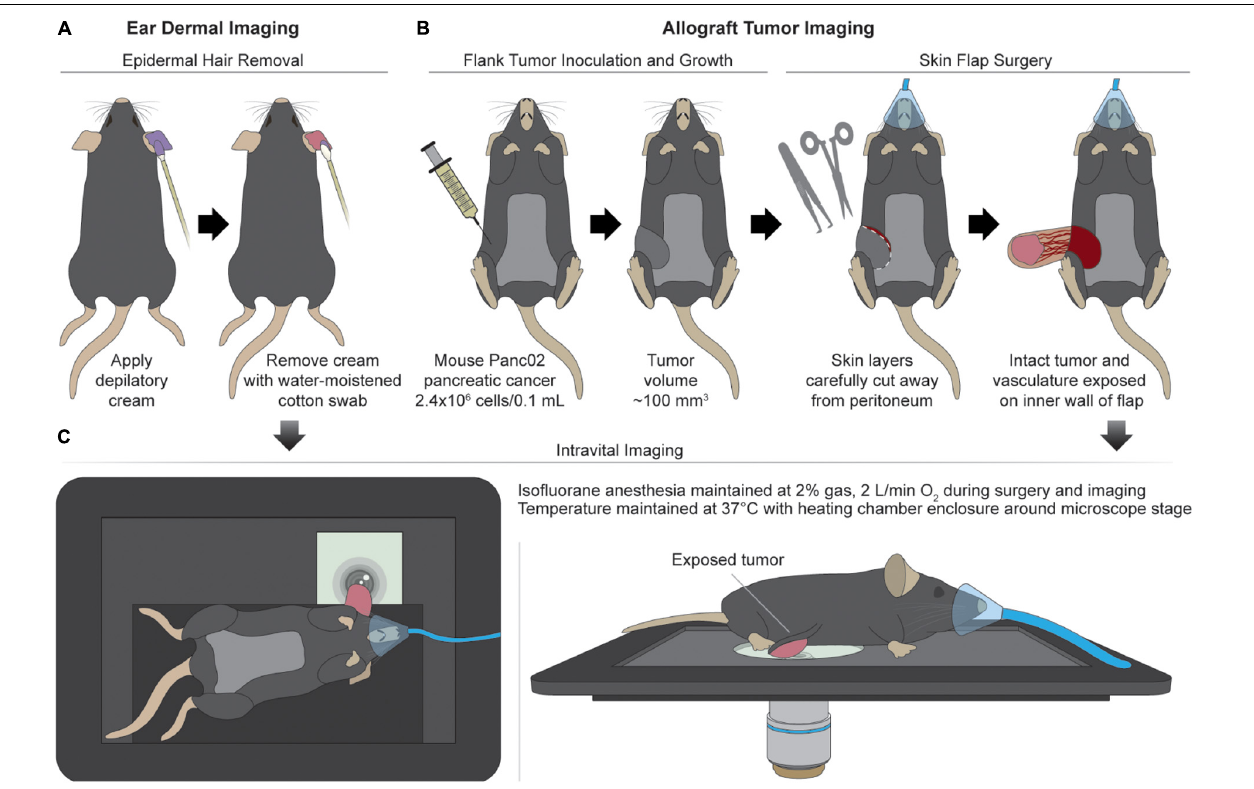
FIGURE 1 | Mouse surgical preparation and intravital imaging setups. (A) Ear dermal imaging technique. Mouse is anesthetized and depilatory cream is applied for ∼ 2 min to the ventral side of the mouse ear to remove hair as a source of imaging artifact. Depilated area is cleaned with water-soaked cotton swab. (B) Allograft generation and imaging technique. Mouse is inoculated subdermally with 2.4 × 10 6 Panc02 pancreatic cancer cells (per 0.1 mL) in the flank and allowed to grow to a volume of ∼ 100 mm 3 . After reaching target volume, mouse is anesthetized for surgical exposure of tumor. Superficial incisions are made into skin surrounding the tumor to form a flap separable from the peritoneum and body cavity. The tumor is exposed by peeling the flap away from the body while remaining intact and vascularized. (C) Intravital imaging procedures. For ear dermal imaging, mouse is placed on microscope stage designed with inlay to support mouse body and imaging window on which the cleared ear skin is overlaid. For tumor imaging, mouse is placed on microscope stage and skin flap with attached tumor is overlaid for imaging. Anesthesia and temperature are regulated and maintained during all imaging procedures.